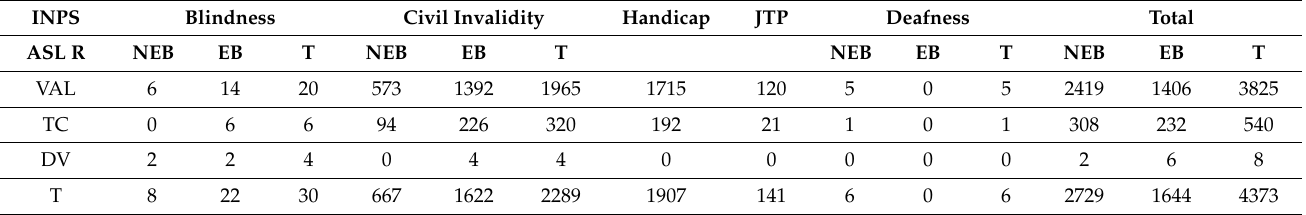
DV = direct visit. T = total. JTP = Job Targeted Placement.